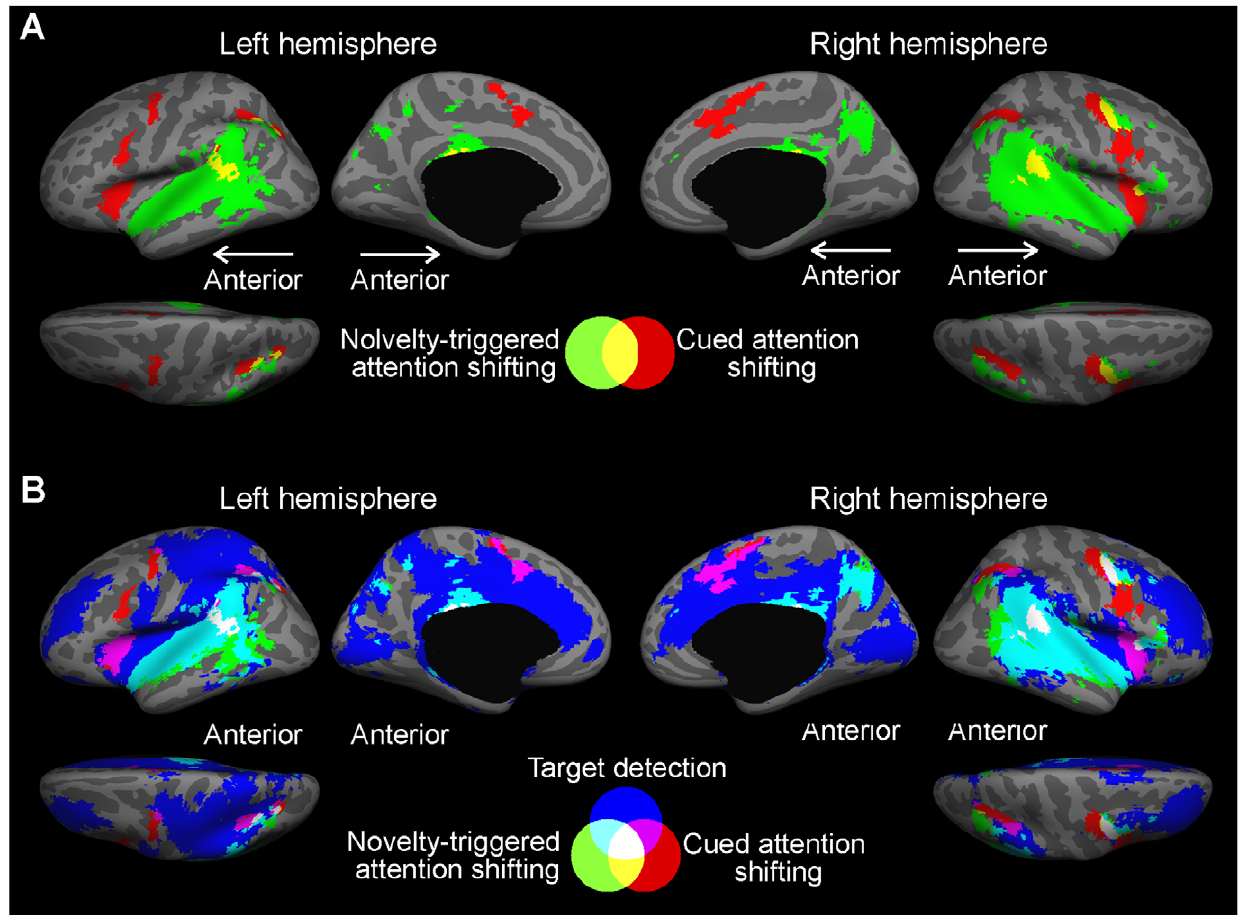
Figure 3. Anatomical labeling of significant activations during the different task conditions based on group ( N =18) results. A. Comparison between cued attention shifting (Cue + Standards vs. Standards Only) and novelty-triggered attention shifting (Cue + Novel + Standards vs . Cue + Standards) conditions would seem to support a distinction between a dorsal voluntary (pSTG, PT, STS, anterior insula, superior IPS, IFC, FEF/PMC, mSFC, aMCC) and a more ventral (primary and non-primary auditory cortex, TPJ, inferior IPS, precuneus, PCC, right IFC) involuntary attention system. B. When also overlapped with areas activated during target discrimination (Cue + Target + Standards vs . Cue + Standards), areas purely related to voluntary attention shifting would seem to be focused to the right and left PMC, including the FEF that is also partially activated by the other conditions, and to the superior/posterior aspect of IPS. Involuntary attention shifting (Cue + Novel + Standards vs . Cue + Standards) seems to concentrate in the right inferior IPS and posterior STS (MT/MTG) areas. Interestingly, the anterior insula seems to be activated during both conditions needing voluntary attentional control. At the same time, in the auditory cortices, voluntary attention shifting (Cue + Standards vs. Standards Only) seems to be restricted to the posterior ‘‘where’’ area, while both target discrimination and involuntary orienting to novel sounds activated virtually all superior temporal auditory areas.